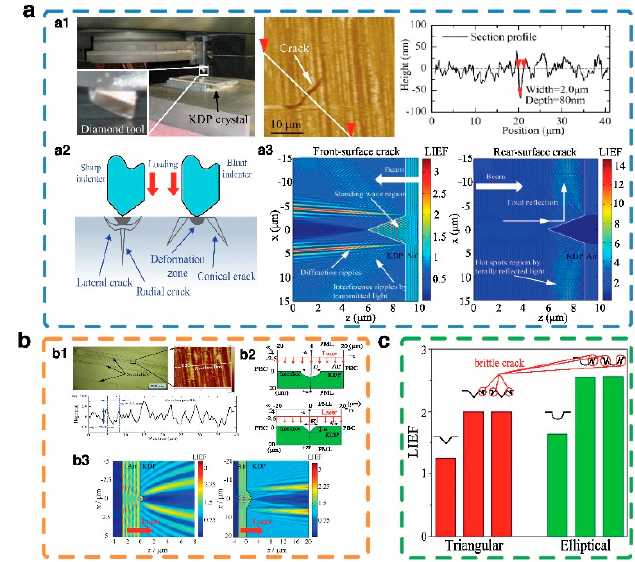
Figure 12. Exploration of the influence of defects on energy deposition. ( a ) Cracks; ( b ) Scratches; and ( c ) Plastic scratches with brittle cracks. a1 and b1 are the topography images of defects; a2 and b2 are the simplified defect models; and a3 and b3 are the intensity distribution with simplified defect model simulated by finite-difference time-domain (FDTD) [18,78,79].